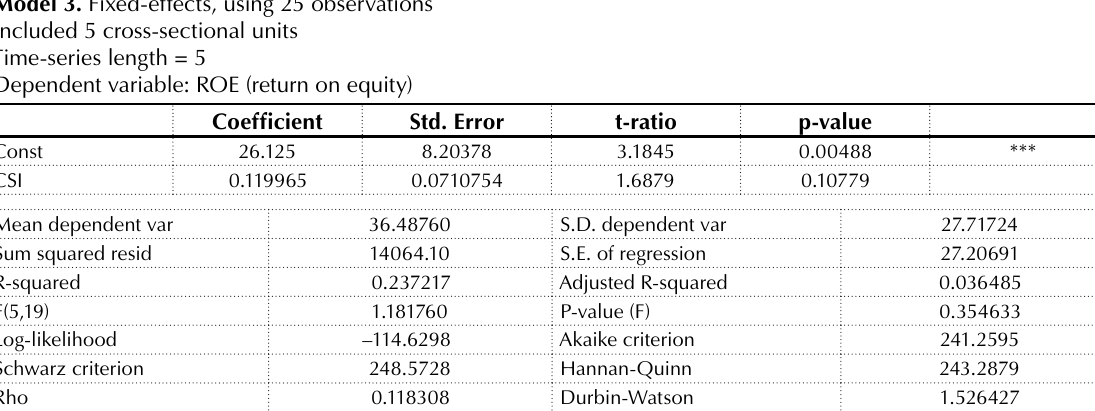
Table 3. Relationship exists between corporate social investment (CSI) and return on equity Model 3. Fixed-effects, using 25